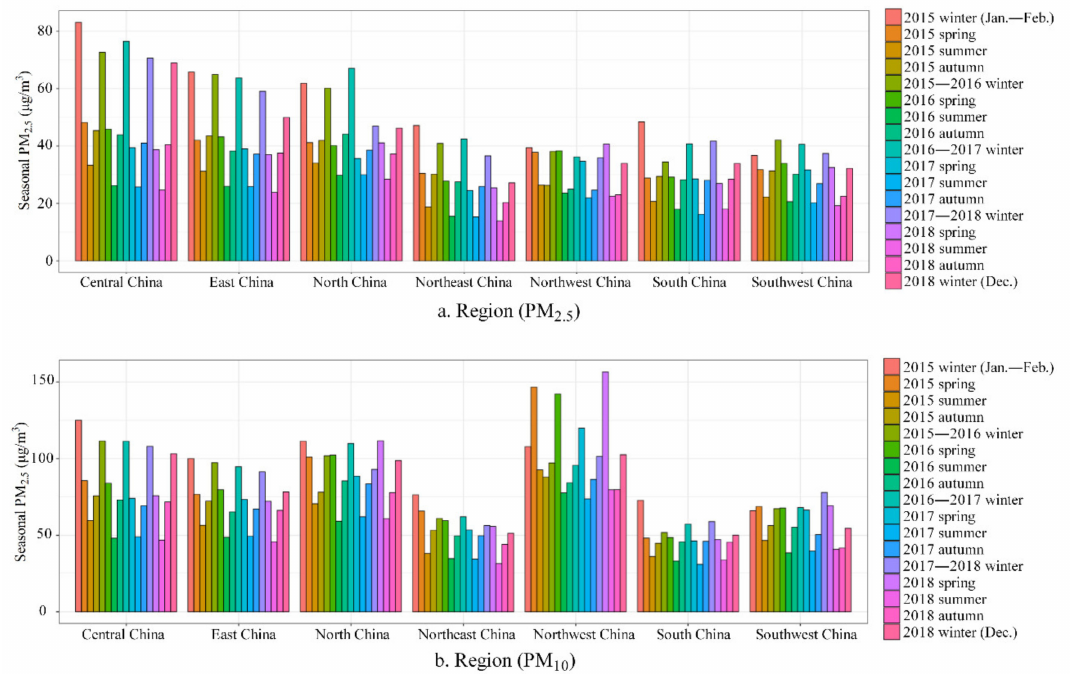
Figure 13. Seasonal means of predicted PM 2.5 ( a ) and PM 10 ( b ) concentrations from 2015 to 2018 for seven geographical regions in mainland